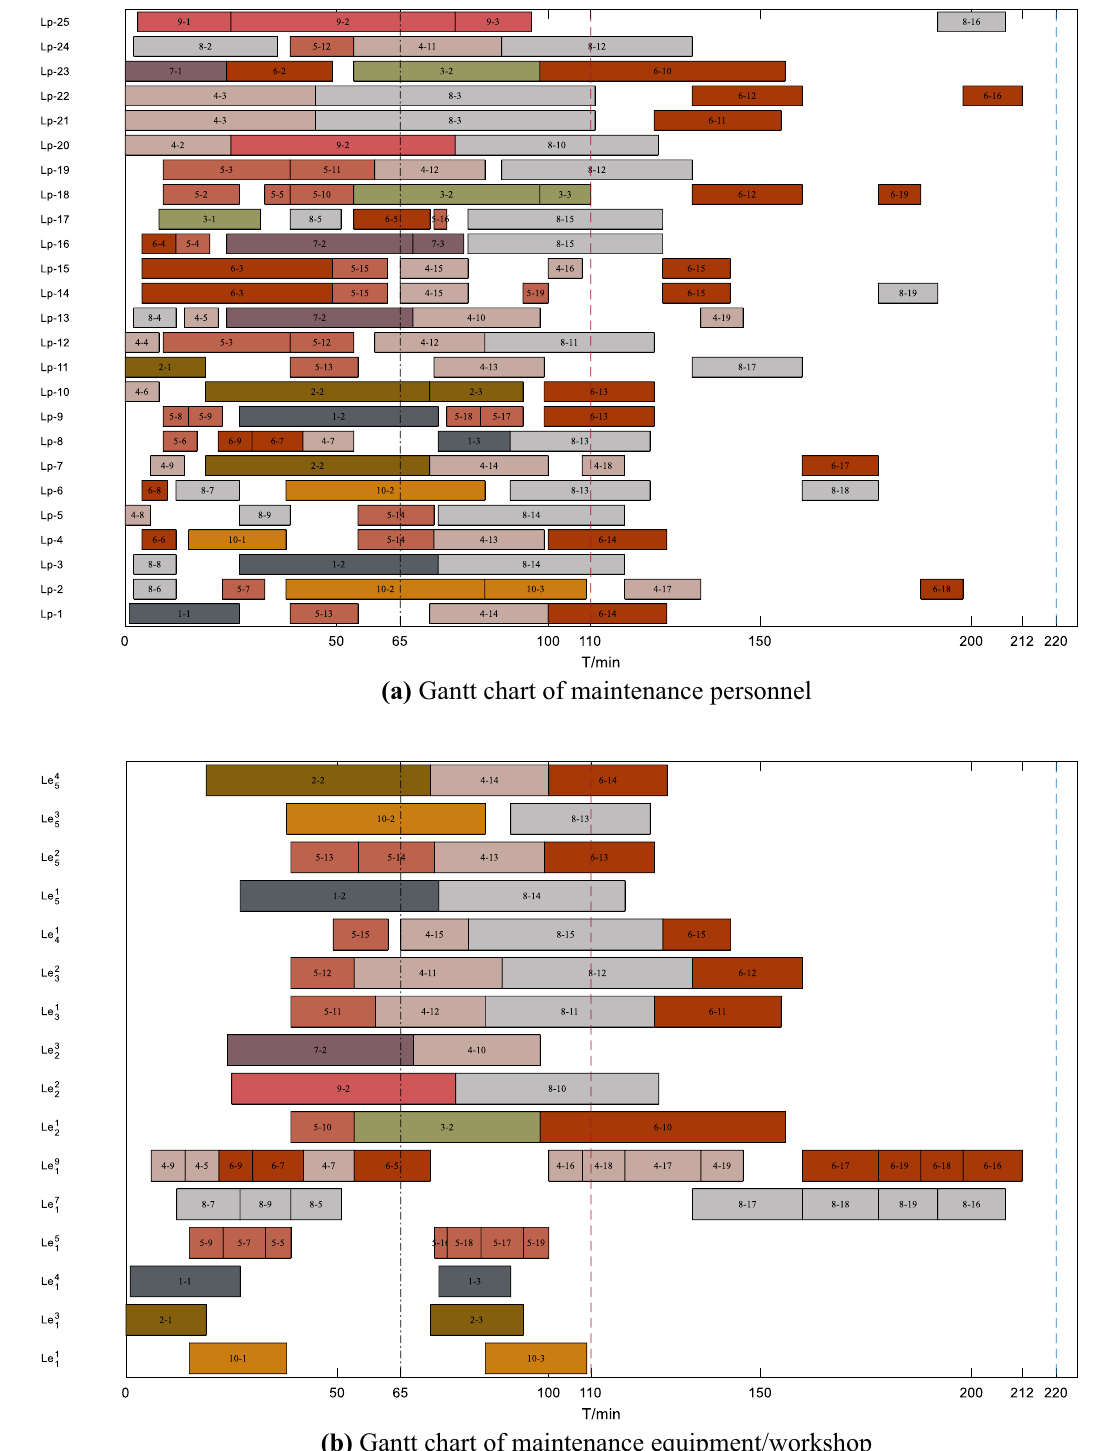
Fig. 15 Complete rescheduling of delay event I for 10 carrier-based